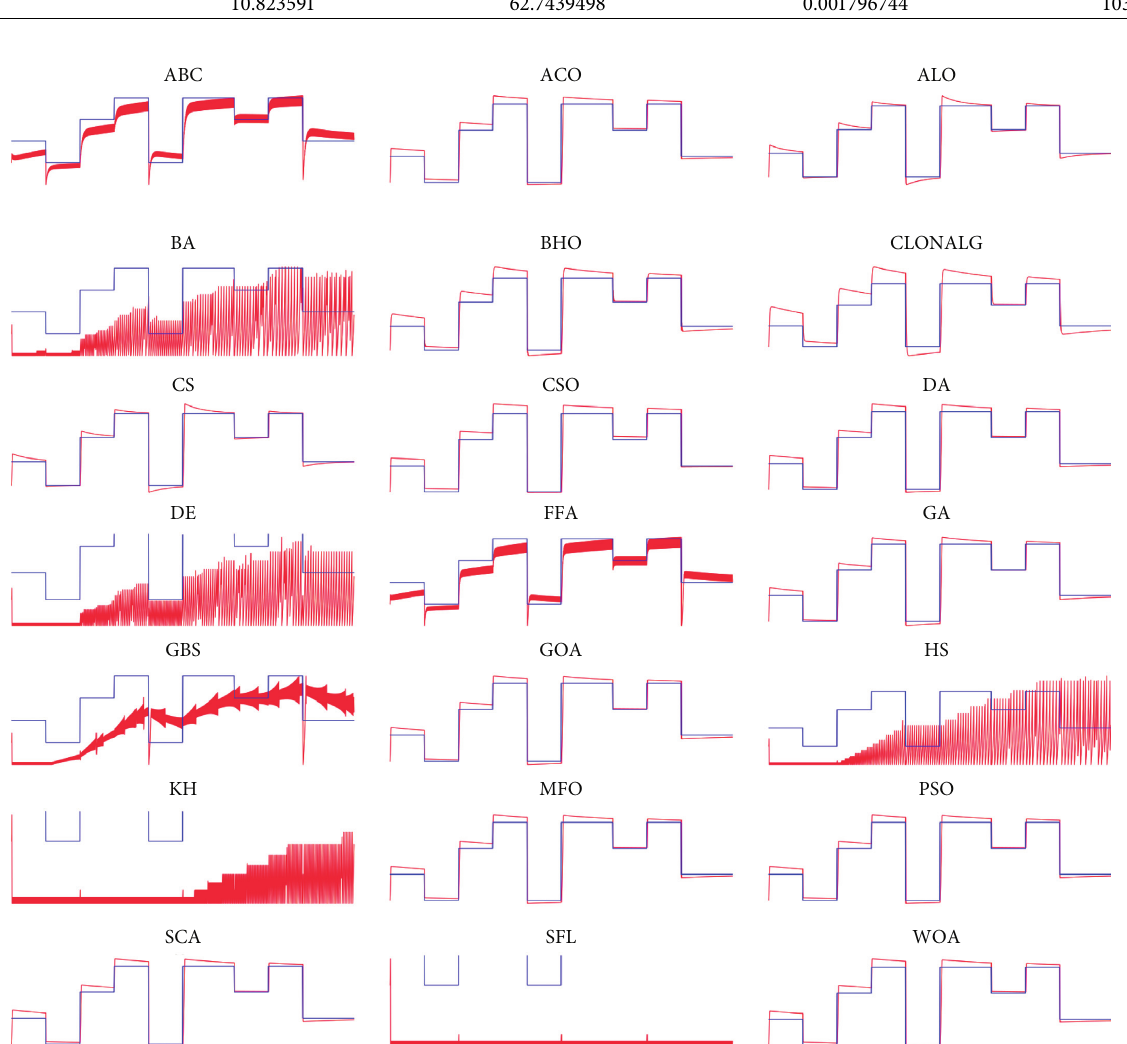
Figure 6: Results of 21 optimization metaheuristics using a fitness/objective function f is target/output signal and the blue line is desired signal, see equation (2) and Table 6. Parameters have been set to the same values for all algorithms, 100 iterations, and a population size of 15 individuals with ( K p , K i , K d ) ∈ [ 0 . 001 , 100 ] , in order to get a similar testing environment for all algorithms.